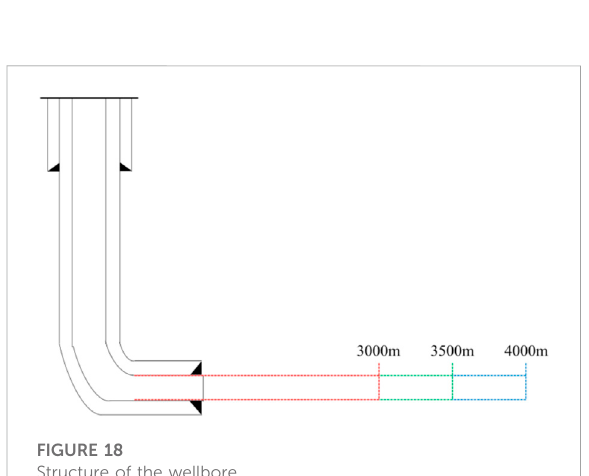
FIGURE 17 Effect of ROP on pressure loss.